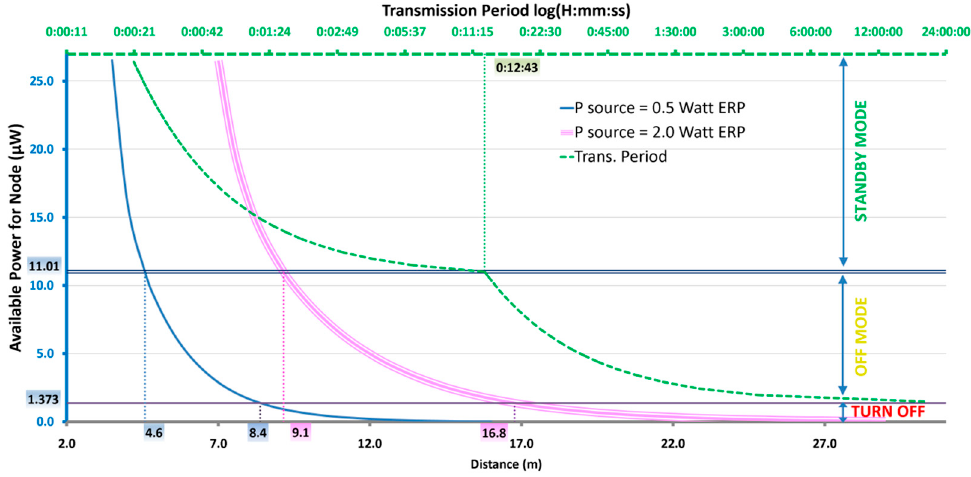
Figure 17. Combined graph showing the relationship between distance, extracted power and transmission periods.